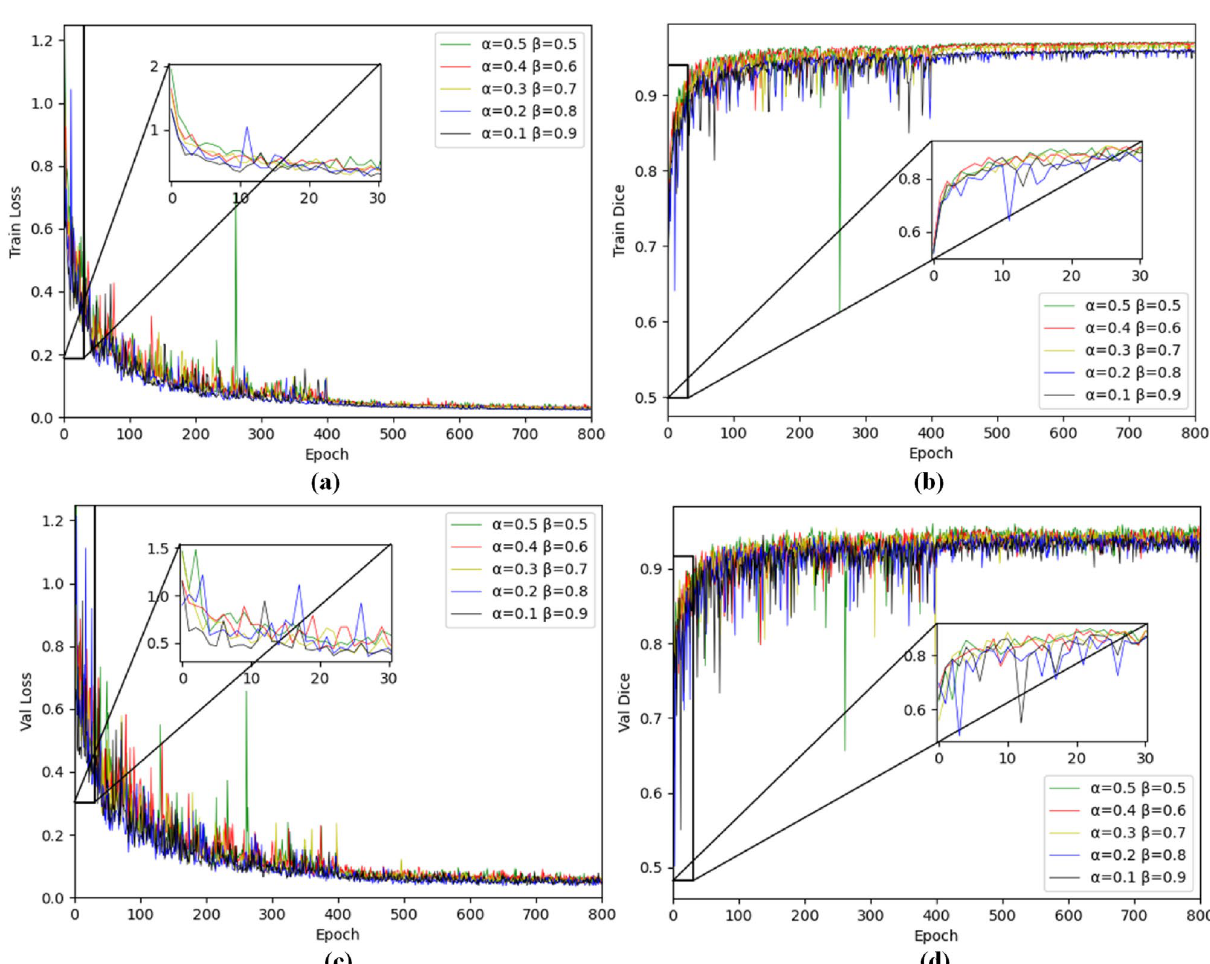
Figure 3. Visualization of loss and accuracy in training and validation process on LiTS17 dataset. ( a ) training loss, ( b ) training accuracy, ( c ) verification loss, and ( d ) verification